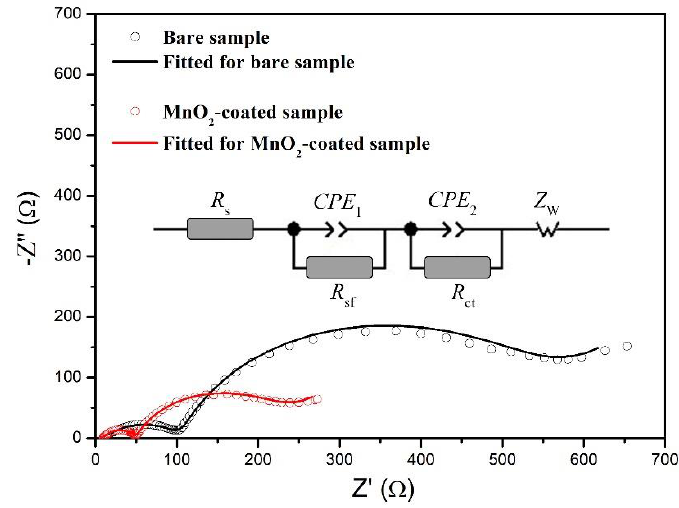
Figure 8. Nyquist plots of the bare and MnO 2 -coated LTMO and the equivalent circuit for fitting.